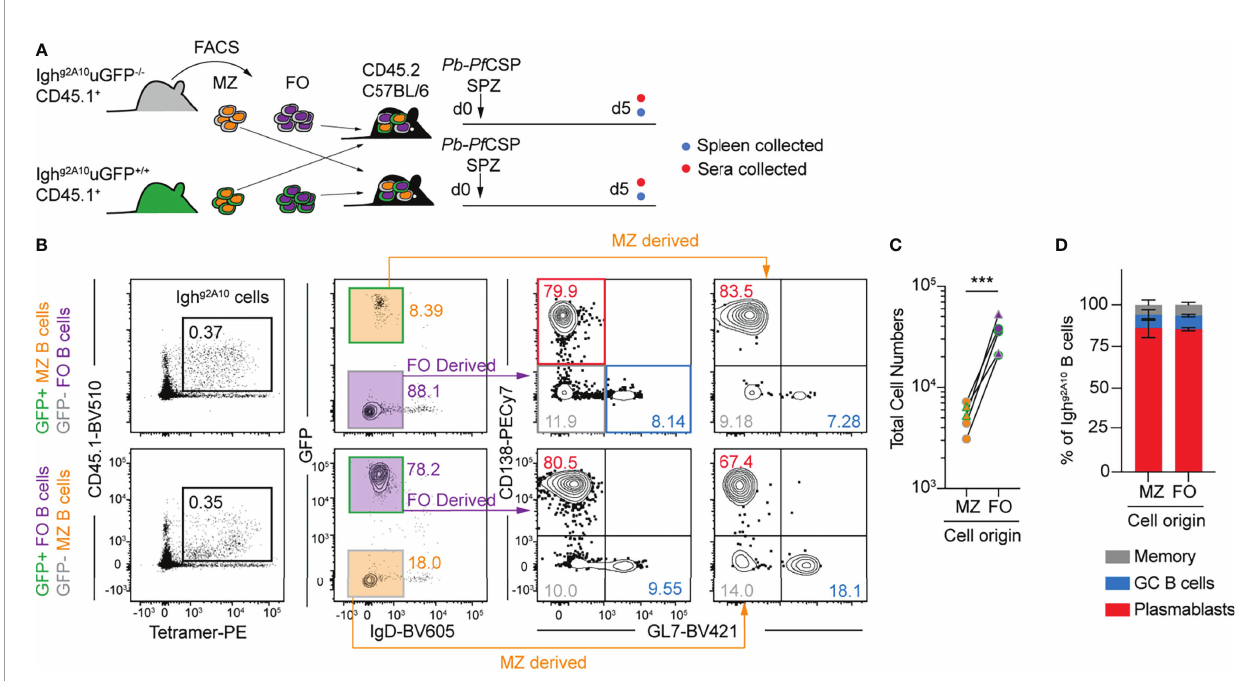
FIGURE 2 | Marginal zone and follicular B cells contribute to the early Pf CSP-speci fi c B cell response. (A) Schematic depicting the experiment strategy for co- transfer of 5 x 10 3 marginal zone (MZ) and follicular (FO) Igh g2A10 B cells prior to immunization with 5 x 10 4 Pb-Pf CSP SPZ with splenic immune response assessed at day 5 post-immunization. (B) Representative fl ow cytometry gating plots for identi fi cation of Igh g2A10 B cells 5 days post-immunization, pre-gated upon singlets, lymphocytes, Dump-negative, B cells [CD19 + ± CD138 + ]. Cells deriving from MZ or FO can be identi fi ed by expression of GFP. The plasmablast (PB) or germinal centre (GC) phenotype of these cells is depicted by subsequent staining for CD138 or GL7. (C) Quanti fi cation of the total number of responding Igh g2A10 B cells 5 days post-immunization, highlighting the original subset they were derived from. (D) B cell phenotype as a percentage of the total responding Igh g2A10 B cells. Results from two similar transfer experiments with at least 2 mice per group. Analyses were performed using a linear mixed model, cell type set as a fi xed experiment effect and the different experiments blocked to account for random effects. Abbreviations for p values are: p < 0.001 =